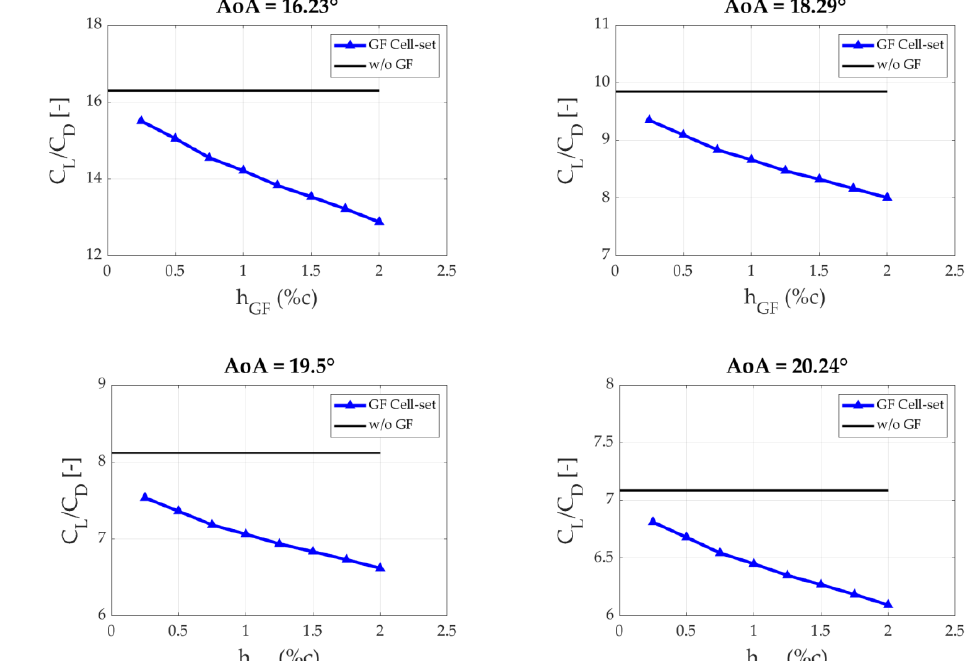
Figure 7. C L / C D lift-to-drag ratio from 0 ◦ to 20.24 ◦ of AoA on the DU97W300 airfoil. Two curves per AoA are represented: black curves represent the C L / C D values of a clean airfoil (no flow control devices) and the triangular-dotted blue curves show the values of the C L / C D ratio for each GF length from 0.25% to 2% of the chord length. Table 2. C L / C D lift-to-drag ratio values for the GF implementation on the DU97W300 airfoil. hGF (% of c) AoA [ ◦ ] No